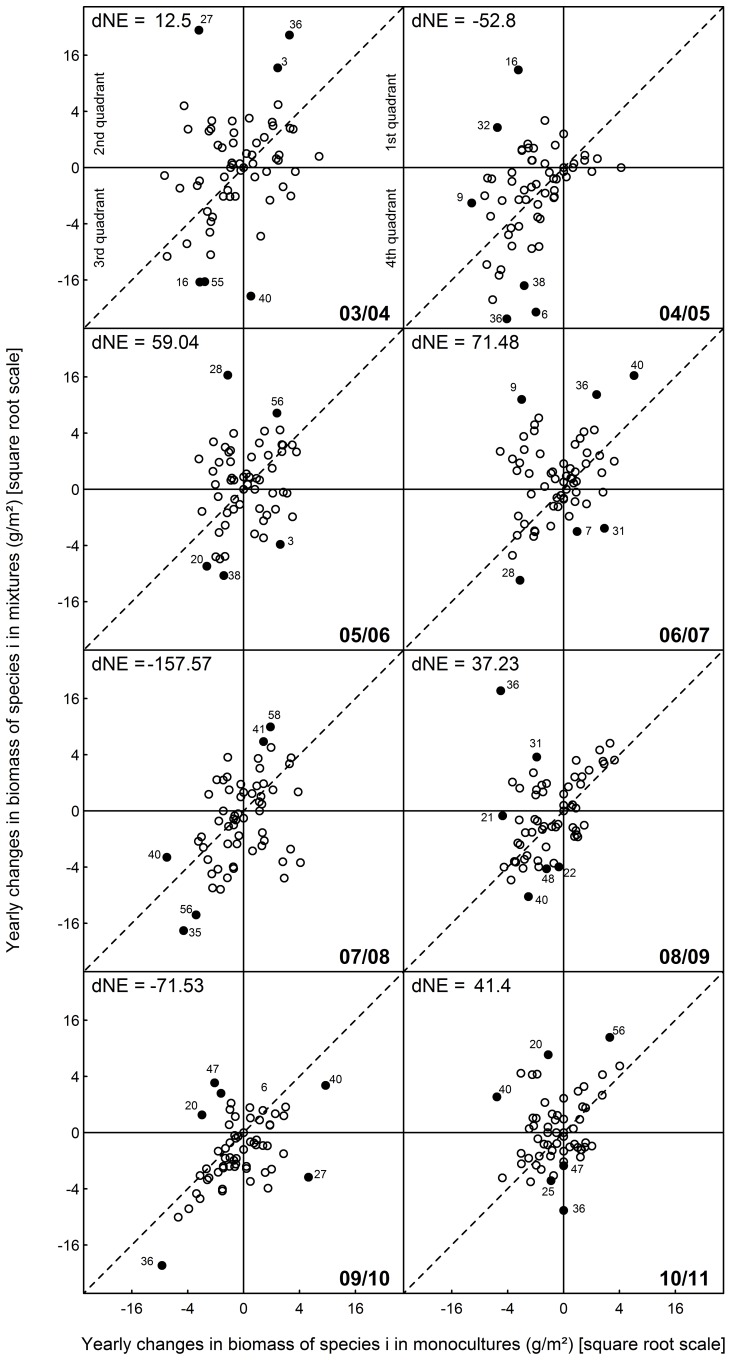
Mean yearly changes in monoculture biomass over mean yearly changes in mixture biomass per species.The panels show annual time intervals during 2003–2011 (as indicated in the lower right of each panel). The values on the x-axis equal Δ ŶEi = mean changes in the expected yield of a species (monoculture yield divided by species richness); the values on the y-axis equal Δ ŶOi = mean changes in the observed yield of a species (mixture yield; see Methods). A point falling on the solid vertical line indicates that a species has not changed in its expected yield (i.e., in monoculture) during the respective time interval. A point falling on the solid horizontal line indicates that a species has not changed in its observed yield (i.e., in mixture) during the respective time interval. A point falling below the broken diagonal line contributed to a decline and a point falling above the broken diagonal line contributed to an increase in the net biodiversity effect. The perpendicular distance of a point to the diagonal equals the contribution of a particular species to the change in the net biodiversity effect (see Table 2). The small numbers next to the symbols correspond to the species numbers in Fig. 2 and Table 2 and reveal the identity of the six species with the largest positive or negative contributions to changes in the net biodiversity effect. “dNE” indicates the absolute change in the net biodiversity effect (in g/m2) during the respective time interval. Note the square-root scale of the axes. The two most extreme values are not displayed to allow for a better scaling. These are the values for O. viciifolia during the time intervals 2005/2006 and 2007/2008. They are given in Table 2 (non-transformed); the contribution of O. viciifolia to dNE was 60.9 g/m2 during 2005/2006 and −106.4 g/m2 during 2007/2008.